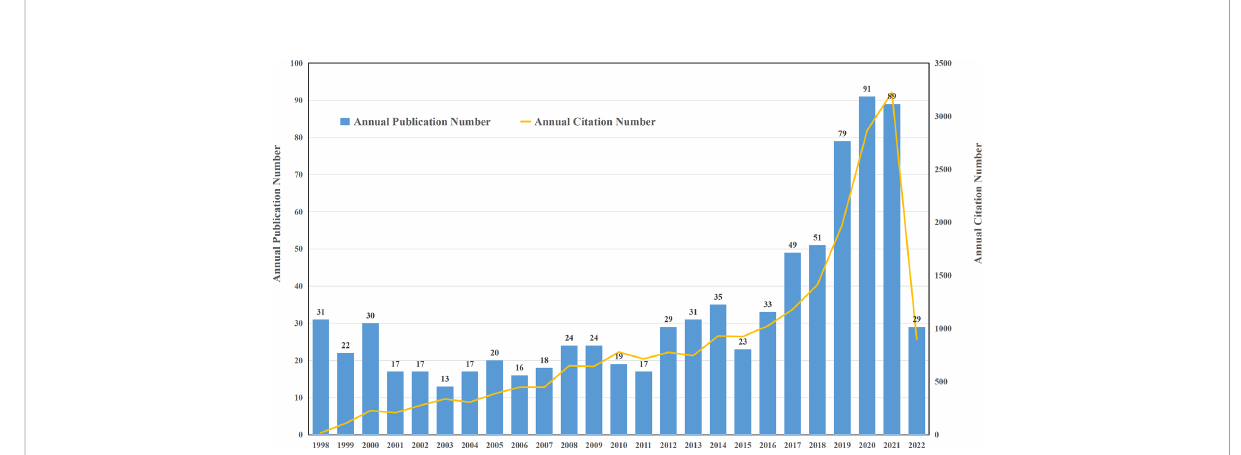
FIGURE 2 Global trend of annual publications and citations related to targeted immunotherapy for MG from 1998 to